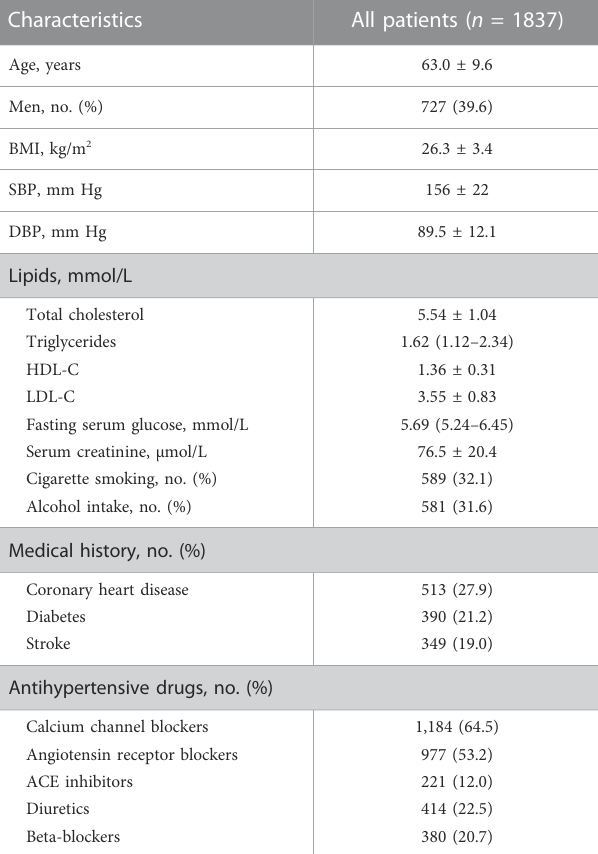
TABLE 1 Baseline characteristics of the patients in this study.